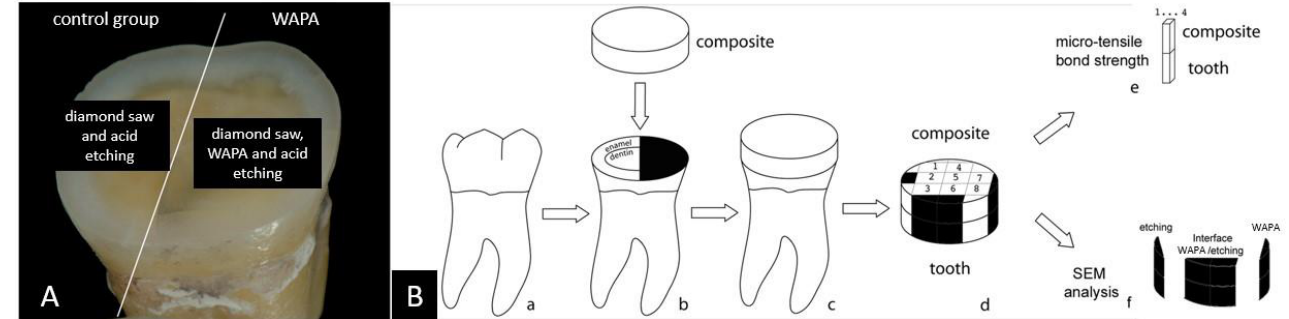
Figure 3. Specimen preparation and schematic drawing of the procedures. In ( A ) the flattened occlusal area of a specimen shows the distinction between the treatments. In ( B ), schematic drawings of each step a–f. From each tooth sample, only the best four specimens out of eight were selected (control group n = 2; WAPA group n = 2) for the microtensile bond strength test and three specimens for each tooth resulting from the cuttings (in black on d and f), were used for the SEM analysis.